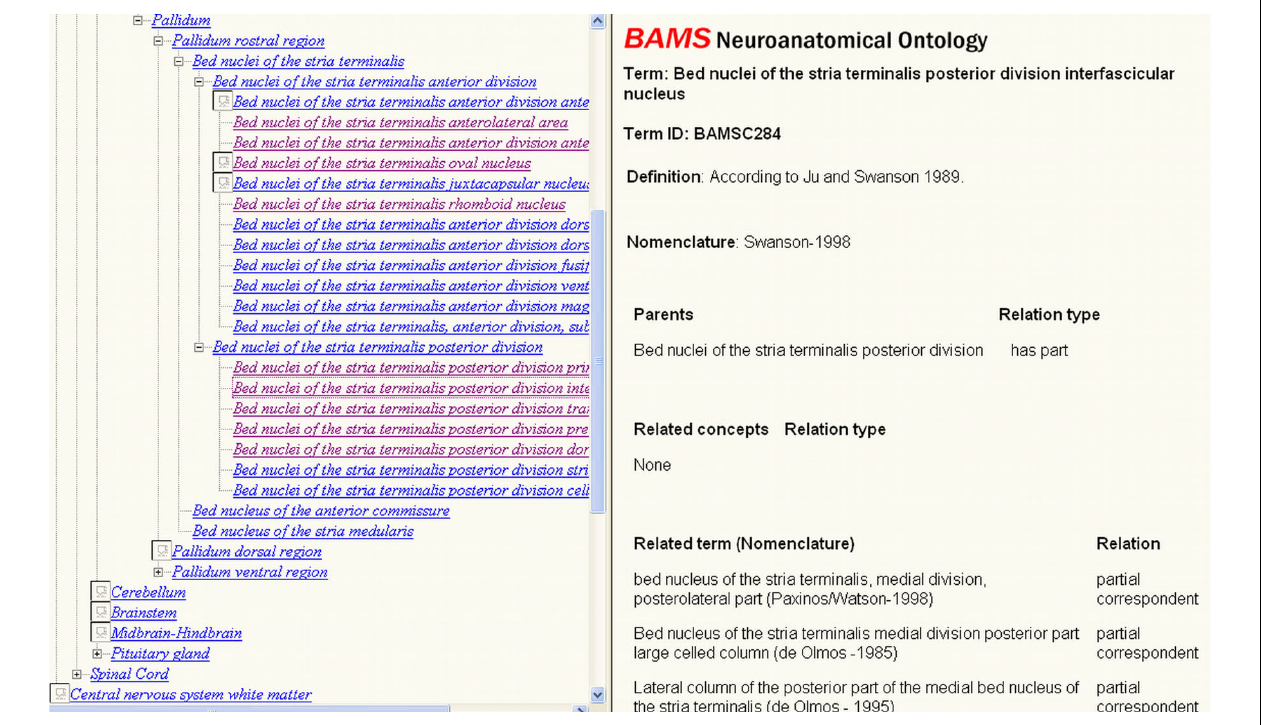
FIGURE 7 | The updated BAMS Ontology (http://retzius.usc.edu/bkms/bams-ontology.html) includes neuroanatomical terms defi ned in different rat nervous system nomenclatures, and their relations with concepts. The ontology can be browsed online, and downloaded as an XML fi le, found at the same